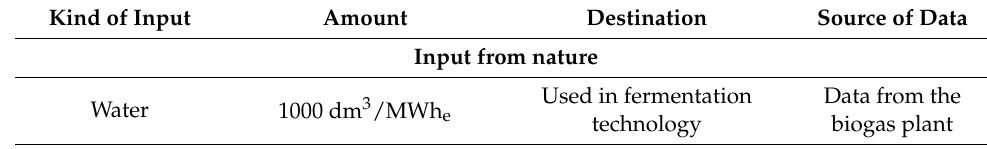
Figure 2. Cases analyzed in the frame of this paper. Table 2. The inventory assumptions for life cycle assessment.